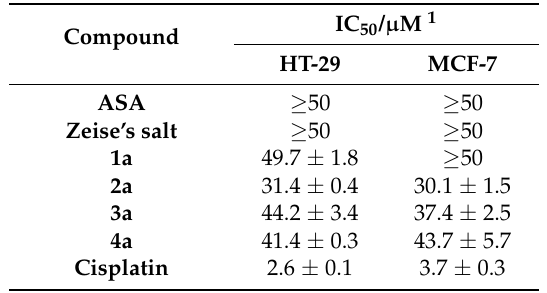
Table 3. Inhibition of the cell growth in colon carcinoma (HT-29) and breast cancer (MCF-7) cell lines determined in a crystal violet cell biomass assay.